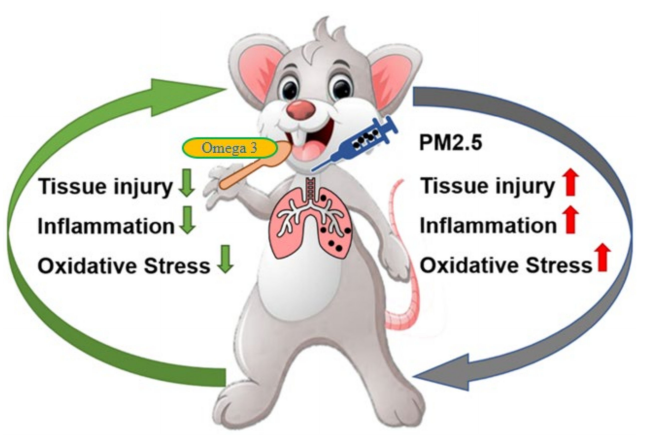
Figure 6. PM2.5-induced toxicity and related mechanisms during PM2.5 exposure and omega-3